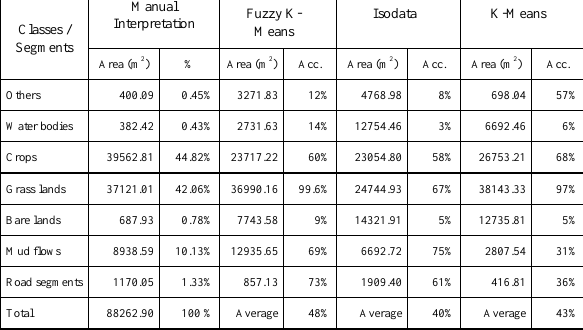
Table 4. Feature extraction without Seed file data